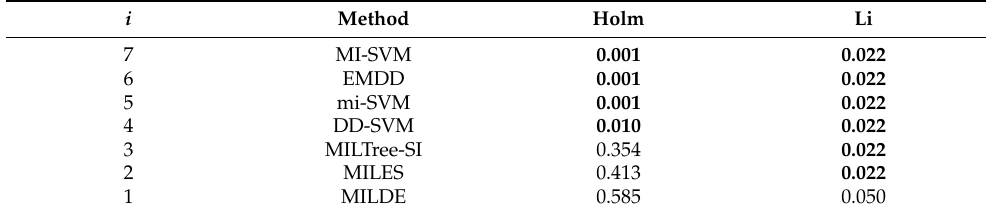
Table 17. Holm’s and Li’s test results for α = 0.05 (Friedman). Holm’s procedure rejects